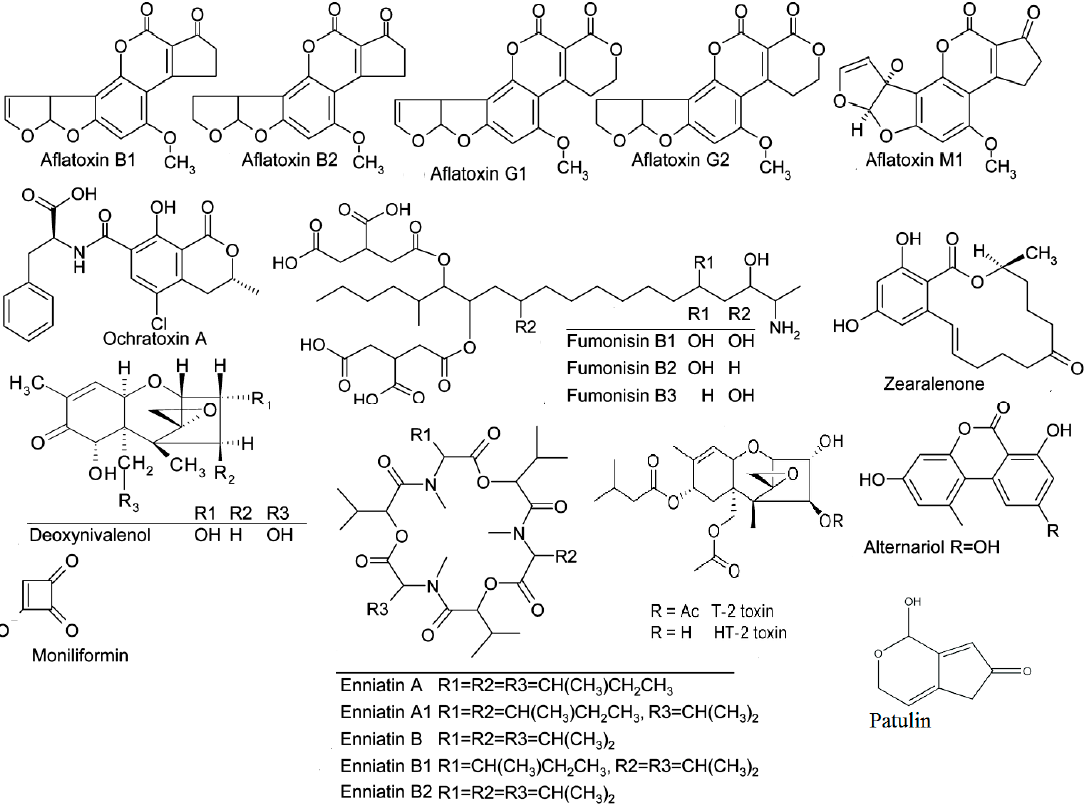
Figure 1. Chemical structures of the main mycotoxins .